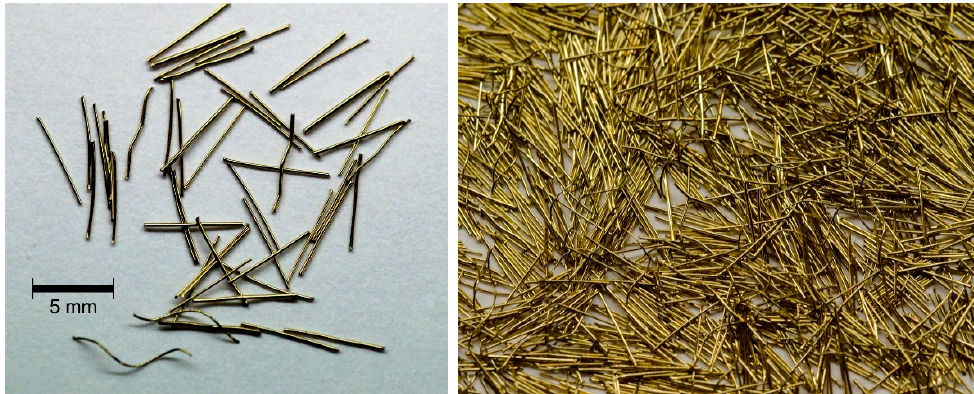
Figure 1. The used steel microfibers with an average length of 6 mm and a diameter of 0.175 mm.